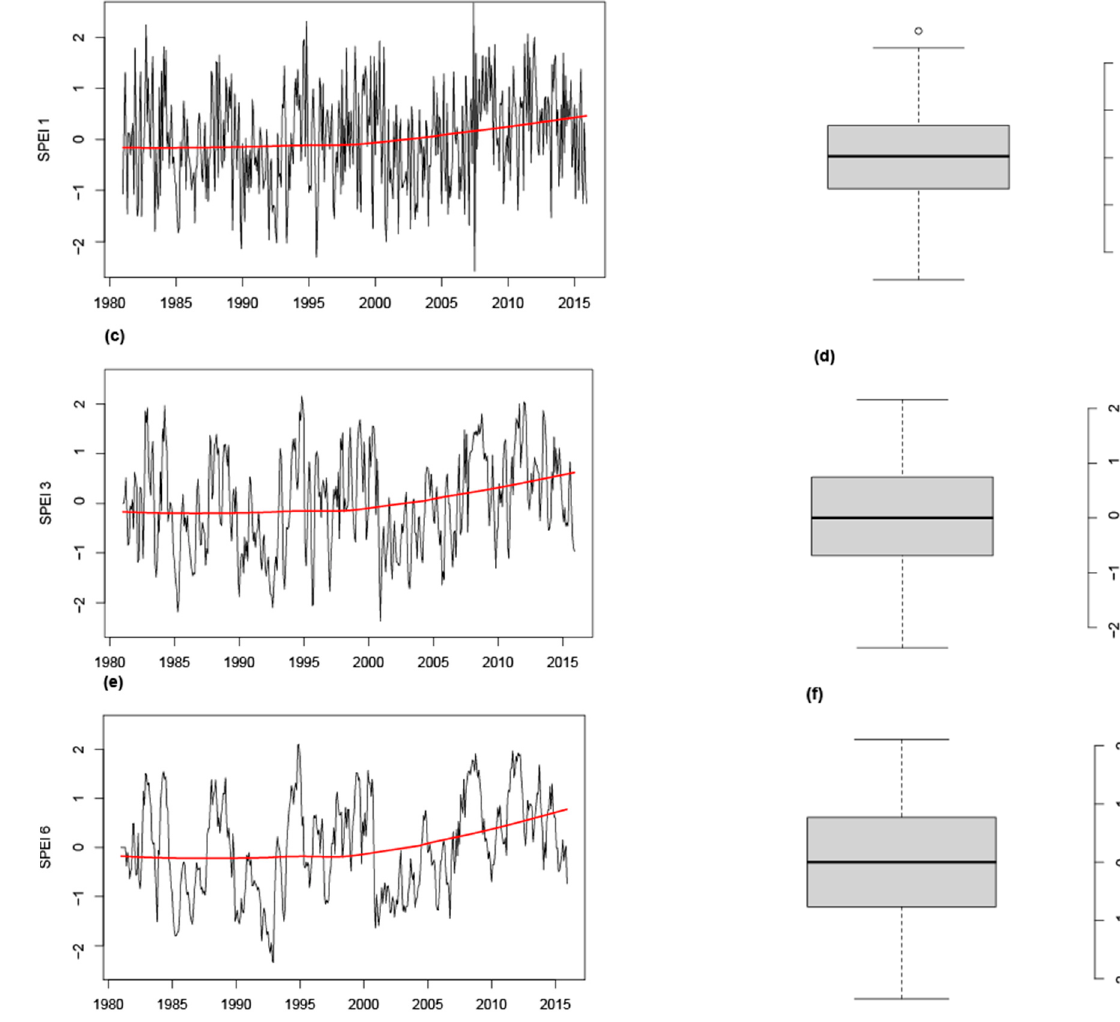
Figure 2. Time series, tendency and distribution of the meteorological drought in 1981–2015. ( a ) SPEI1 time series, and tendency, ( b ) SPEI1 distribution, ( c ) SPEI3 time series, and tendency, ( d ) SPEI3 distribution, ( e ) SPEI6 time series, and tendency, ( f ) SPEI6 distribution.